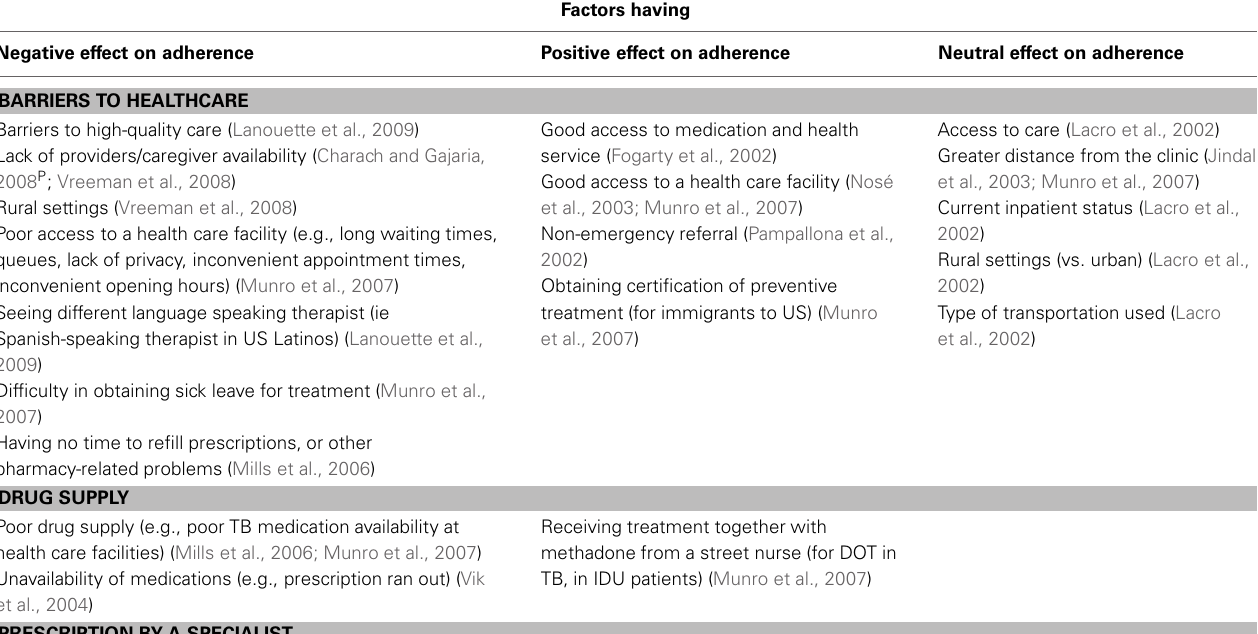
Table 4 | Healthcare team and system-related factors affecting